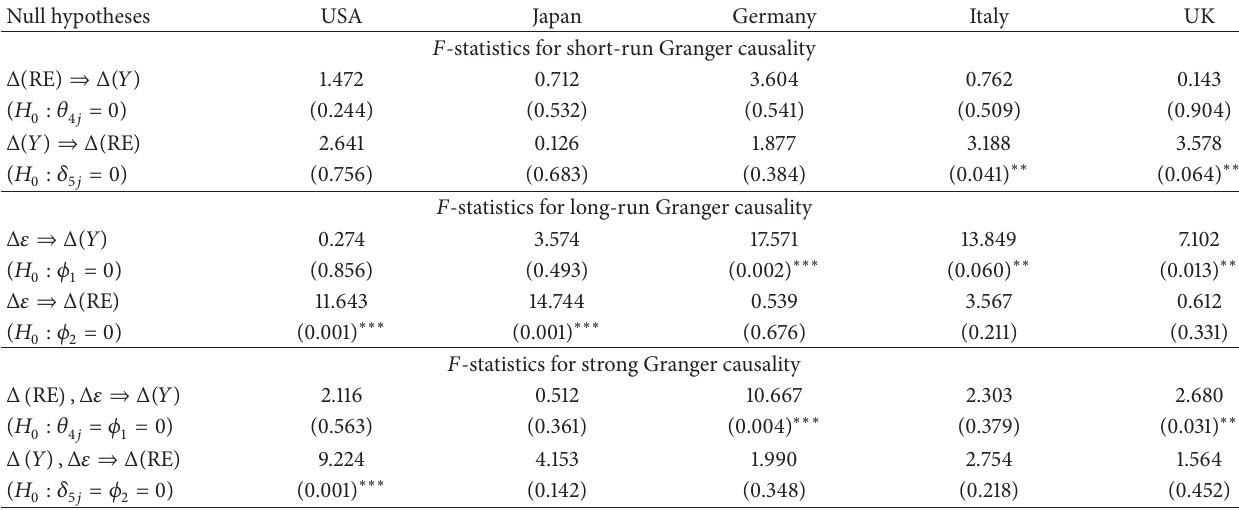
Table 3: Granger causality test